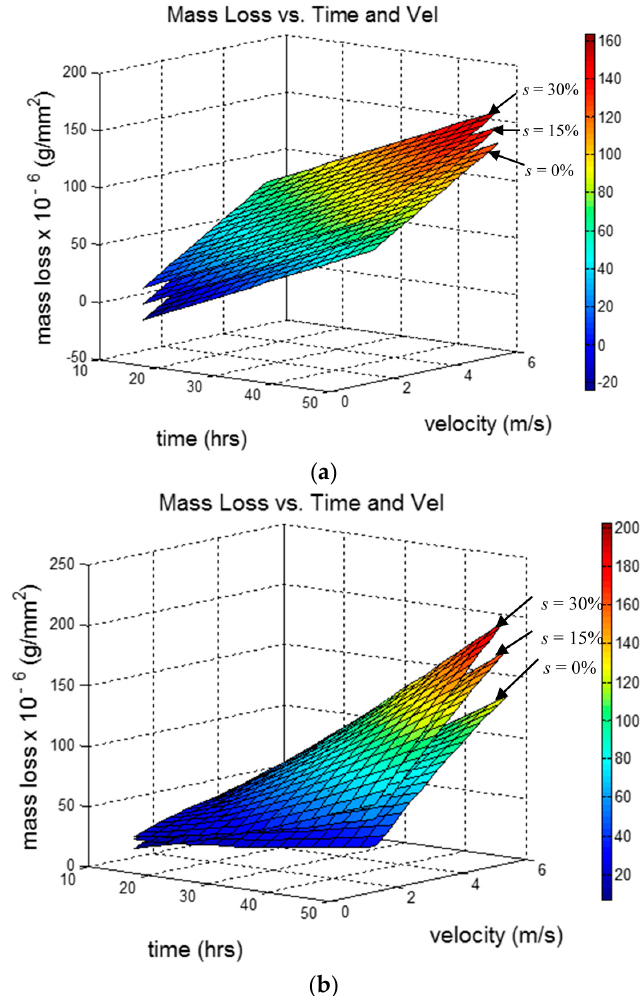
Figure 9. Mass loss versus time and velocity for constant sand concentrations ( s = 0%, 15%, and 30%); ( a ) First-order polynomial; ( b ) Second-order polynomial.